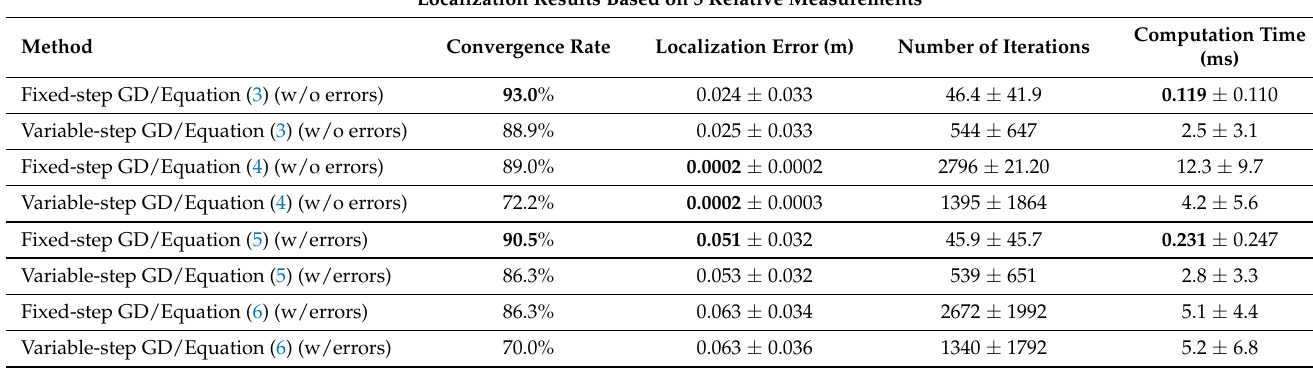
Table 3. Comparative localization results using the different formulations of the estimation problem based on 5 relative measurements, with and without taking into account uncertainty